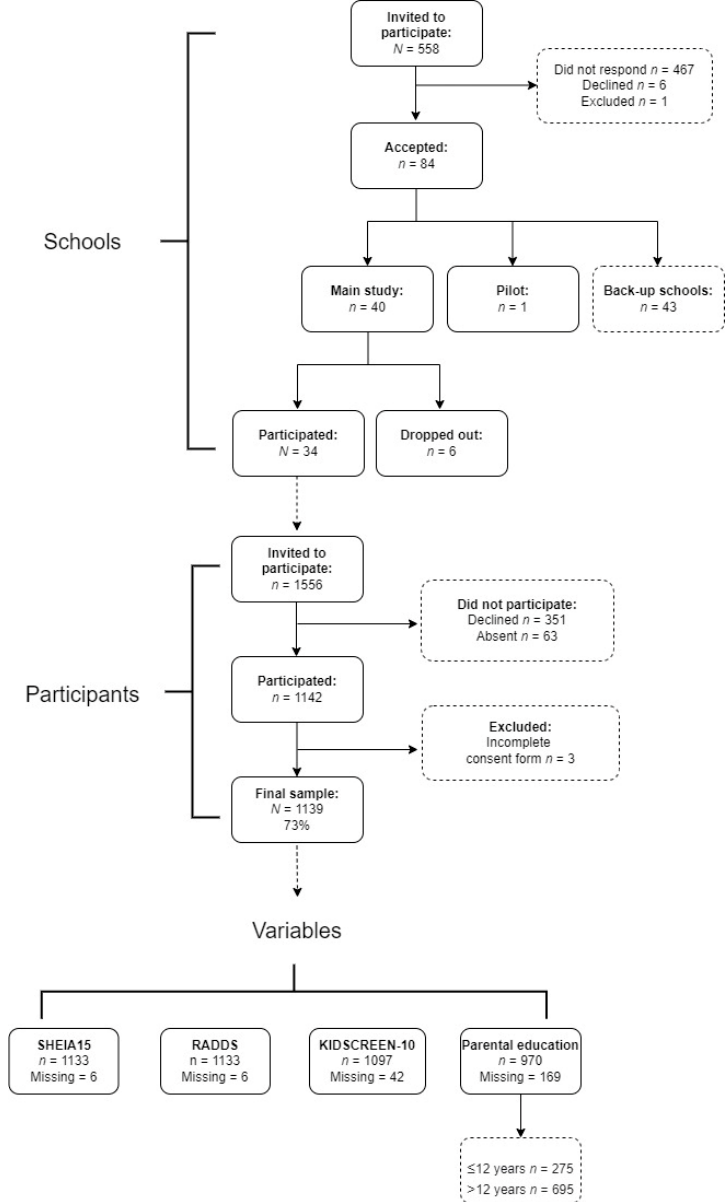
Figure 1. Flowchart showing recruitment of schools and participants and N values for variables.